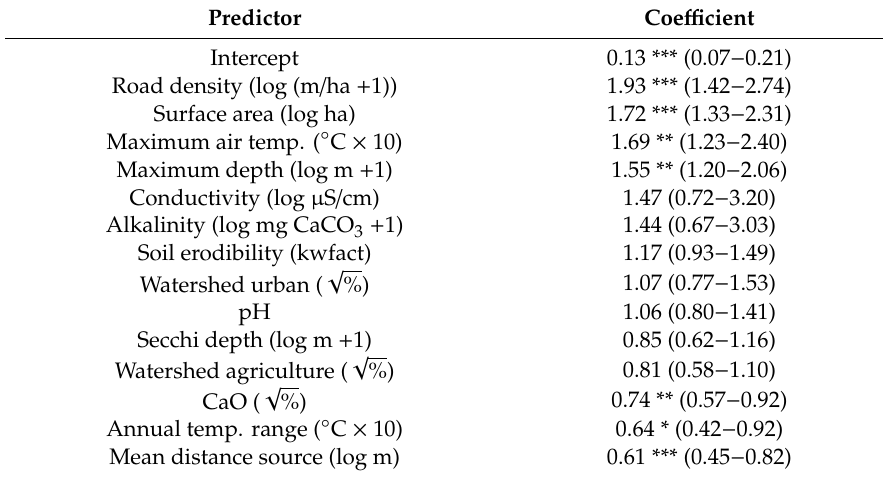
Table 1. Estimated coe ffi cients for Eurasian watermilfoil (EWM) occurrence model developed using data from 657 plant survey lakes. Coe ffi cients expressed as odds ratios calculated for centered and scaled predictors, profile confidence intervals in parentheses. Negative relationships are indicated by odds ratios less than